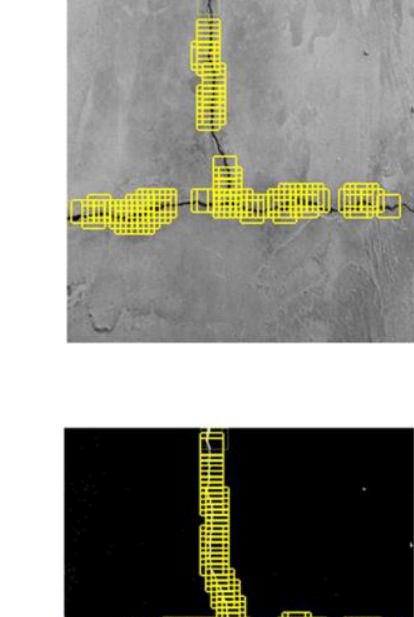
MLP-CNN Figure 18. Accuracy of the original CPD and the MLP–CNN subject to different numbers of crack ROIs in the training set. Figure 19 shows the CPD results using a sliding window with the sliding step of 16 pixels. The